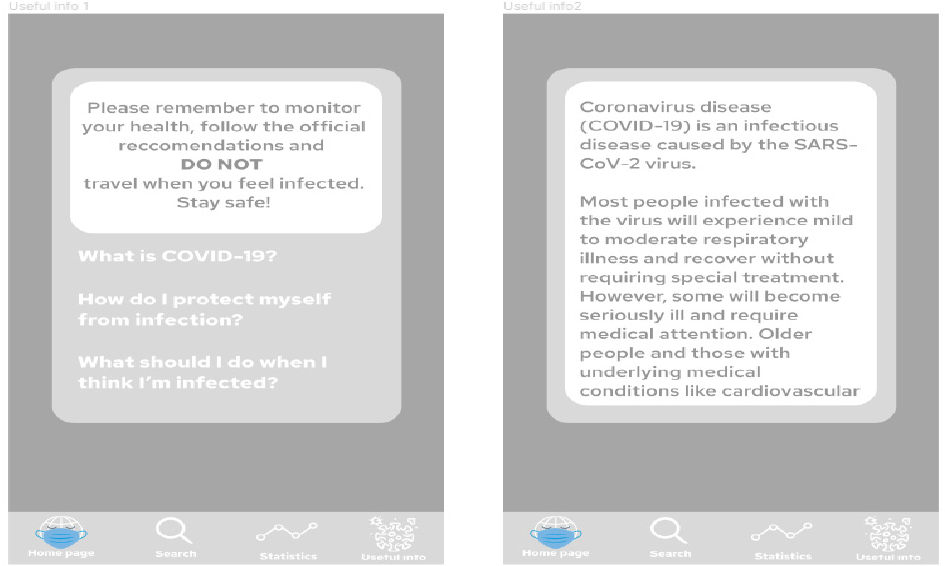
Figure 10. The first and second screen of the information section in the application, that can be chosen from the home screen, and states general information about COVID-19. Source: Authors own elaboration.